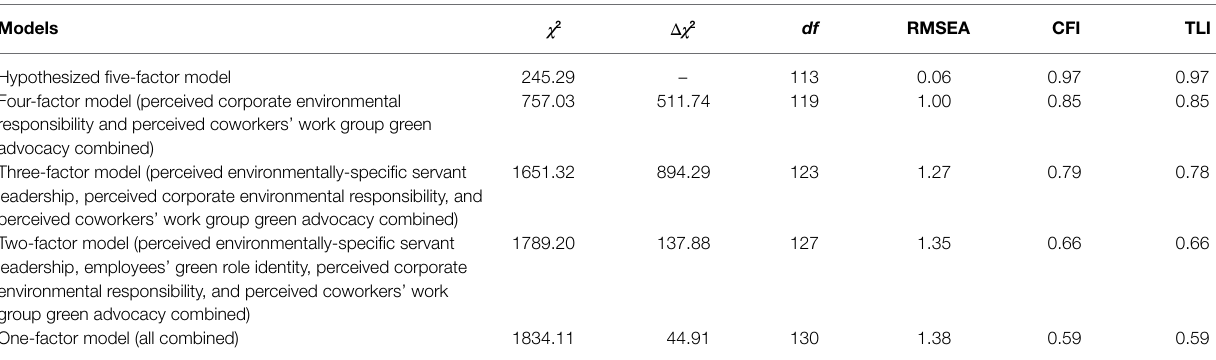
TABLE 1 | Results of confirmatory factor analysis.